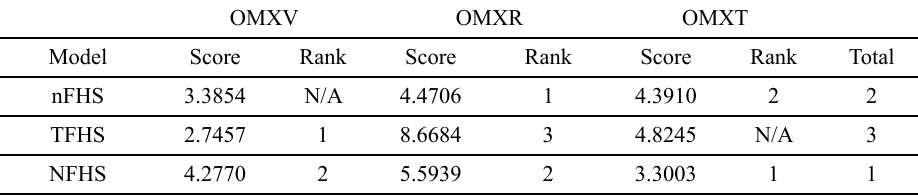
Table 6. Ranking of models according to modified Blanco-Ihle error statistic OMXV OMXR OMXT Model Score Rank Score Rank Score Rank Total nFHS 3.3854 N/A 4.4706 1